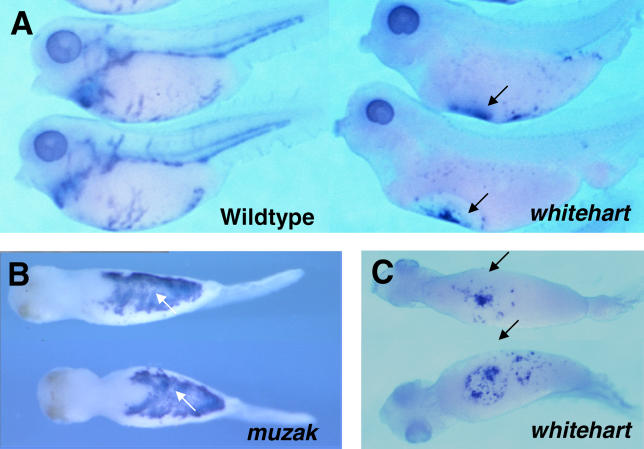

wha Embryos Show Defects in HematopoeisisWhole mount in situ hybridization with α-globin suggests that wha blood distribution is aberrant ([A] and [C]), with reduced globin staining pooled ventrally (black arrows) rather than distributed throughout the circulatory system as in wild-type tadpoles. Comparison of ventral views of wha (C) globin staining with that of muzak (B), a mutant which is impaired in heart function but not hematopoiesis, leading to ventral pooling of normal levels of blood (white arrows), confirms that wha is quantitatively defective in blood formation rather than circulation. See also Tables 6 and 7 for microarray analysis of wha.